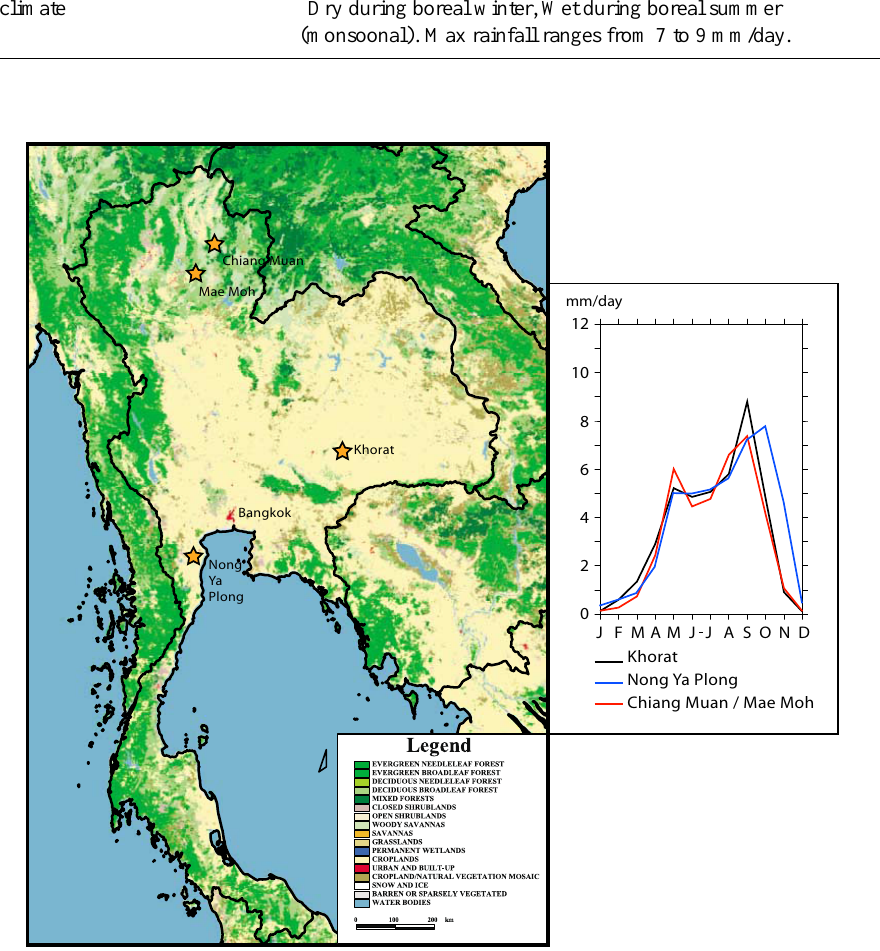
Fig. 1. Map of Thailand indicating the present-day land cover and vegetation types. Modified after Parnell et al. (2003). Plots indicate rainfall seasonal cycle for the three areas of interest. Data from the Climate Research Unit, averaged between 1961 and 1990 (New et al., 2002). Units are mm/day.